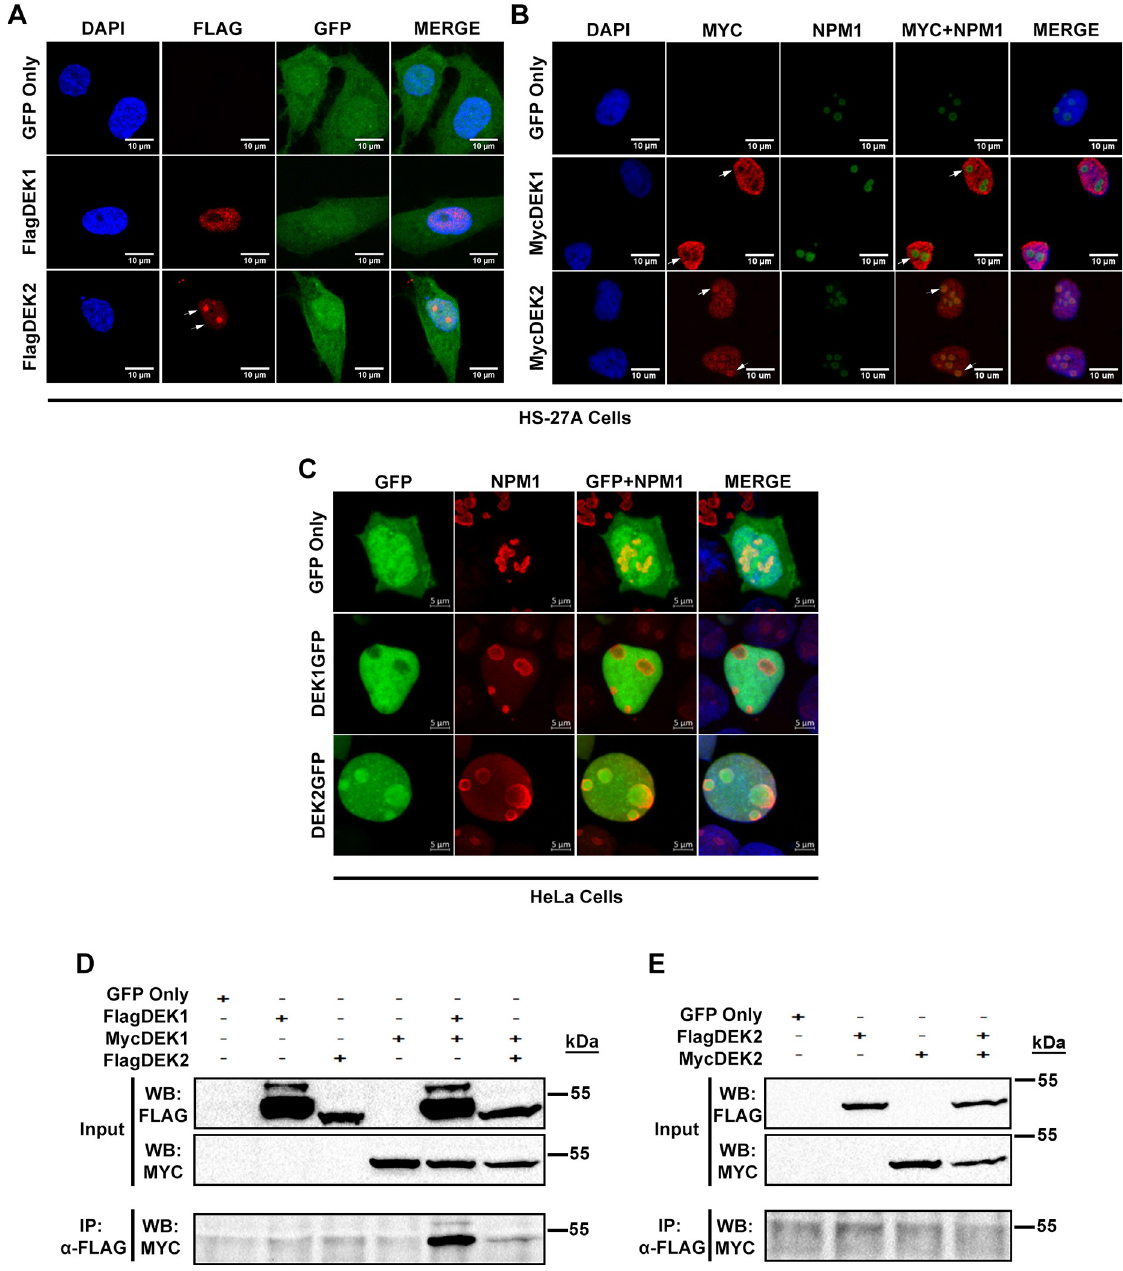
Fig 2. Cellular localization of DEK isoforms. (A, B) HS-27A cells stably expressing Flag-tagged (A) or Myc-tagged (B) DEK isoforms were labeled with anti-Flag or anti-Myc antibodies (red) and anti-NPM1 antibody (green in panel B) using immunofluorescence staining. GFP (green) shows transduction with the retrovirus carrying DEK1 or DEK2 cDNA. DAPI (blue) labels DNA in the nucleus. (C) Immunofluorescence analysis shows the expression and cellular location of ectopic DEK1GFP or DEK2GFP fusion proteins (green) in transiently transfected HeLa cells. Nucleolar marker (labeled with anti-NPM1 antibody (red)) co-localizes with DEK2GFP fusion protein. (D) Co-immunoprecipitation (Co-IP) assays using anti-Flag and anti-Myc antibodies showed that despite the interaction between the large number of FlagDEK1 and MycDEK1 molecules, only a small number of FlagDEK2 and MycDEK1 molecules interact. (E) Co-IP assay in the cells that transiently co-expressed FlagDEK2 and MycDEK2 indicated that DEK2 doesn’t form homodimers.